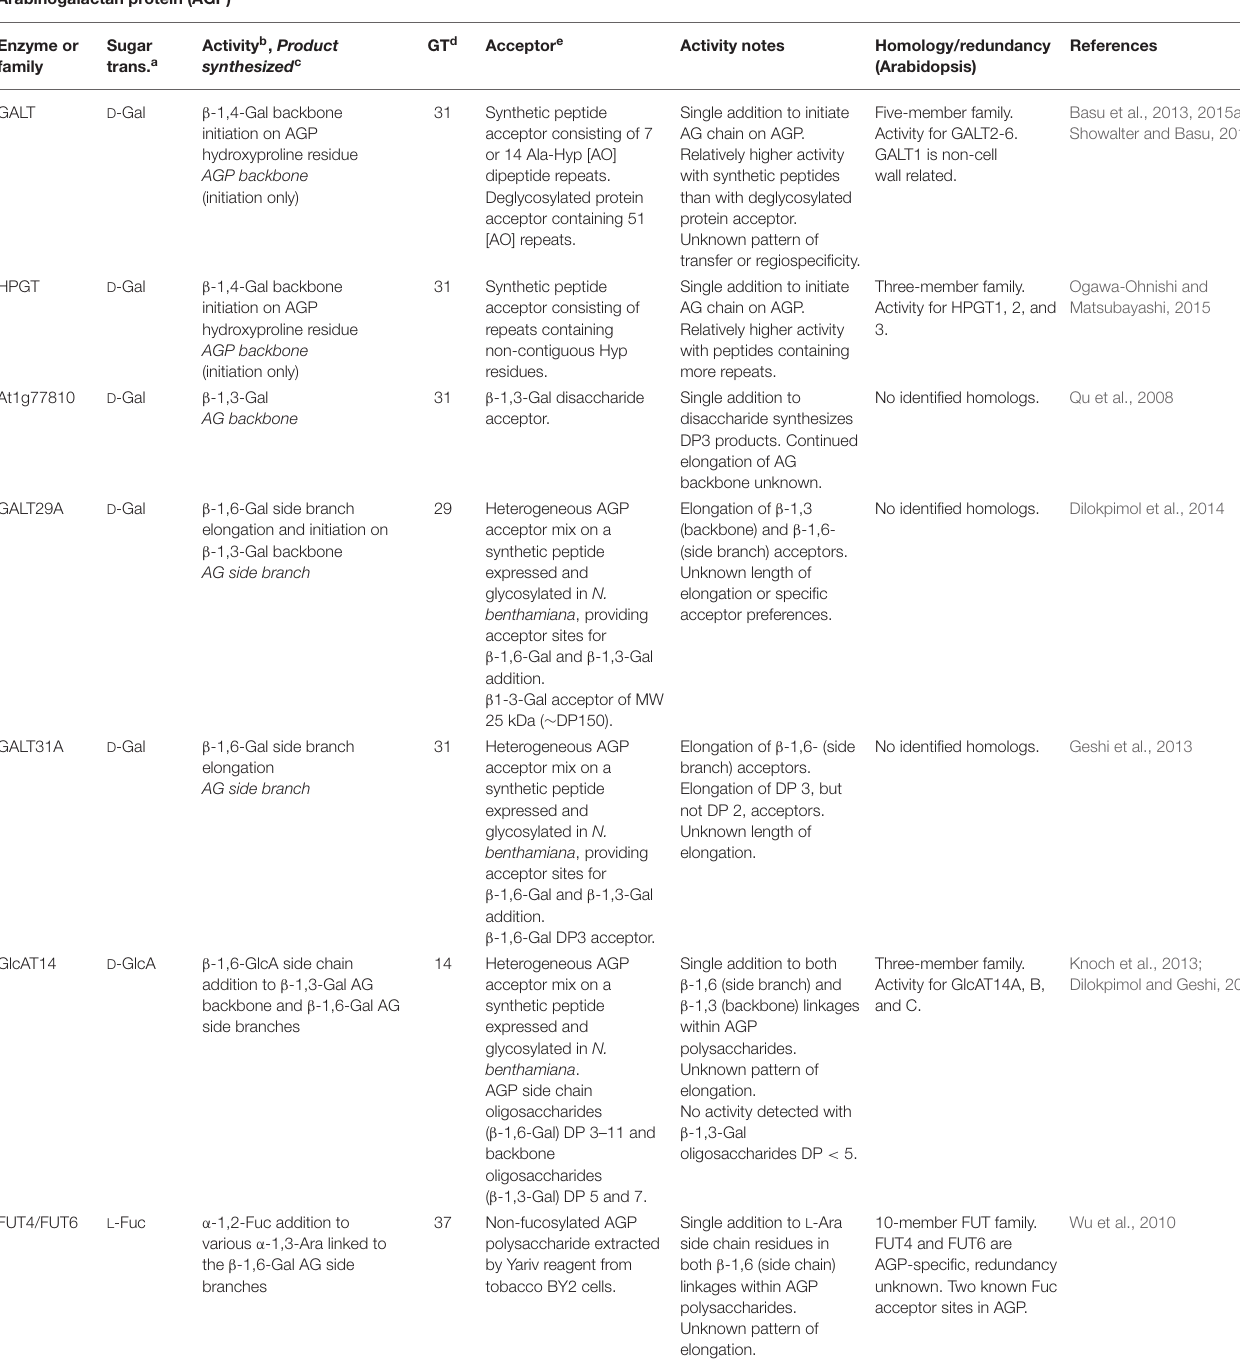
TABLE 6 | Arabinogalactan protein biosynthetic GTs of known function determined by heterologous expression. Arabinogalactan protein